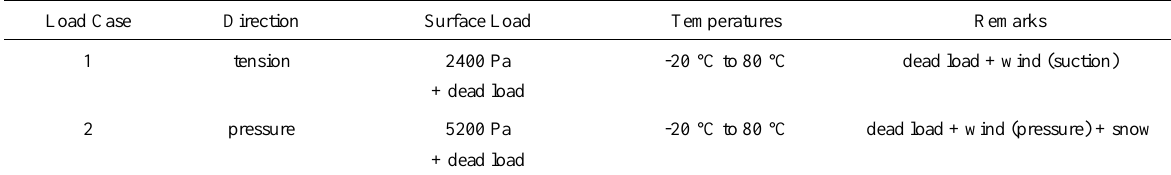
Table 3: Load 2Cases for the global